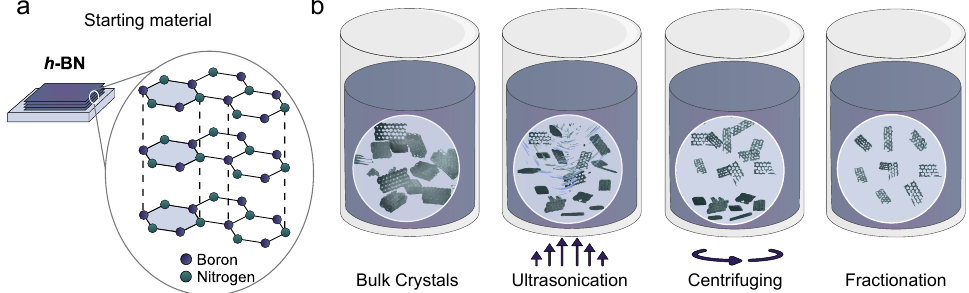
Figure 1. ( a ) The bulk h -BN structure with dashed lines showing the weaker interlayer van der Waals bonding. ( b ) The h -BN exfoliation procedure: a powder of bulk h -BN crystals is dispersed in a mixture of isopropanol and deionised water, the solution is ultrasonicated to induce cleavage of the interlayer bonds, then centrifuged to agglomerate the larger (residual bulk) particles, and finally the supernatant containing the suitably exfoliated particles is extracted by